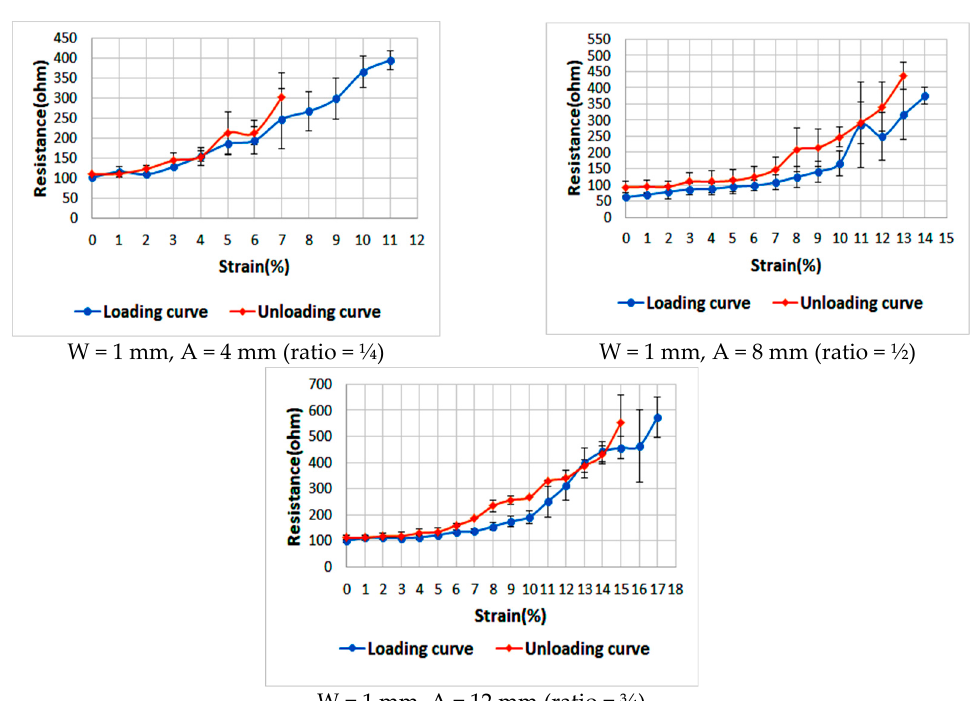
Figure A1. Average resistances of two sinusoidal samples at a width of 1 mm and various amplitudes as the applied strain increases (loading) and decreases (unloading). Error bars indicate the standard deviation in the values of the resistances.